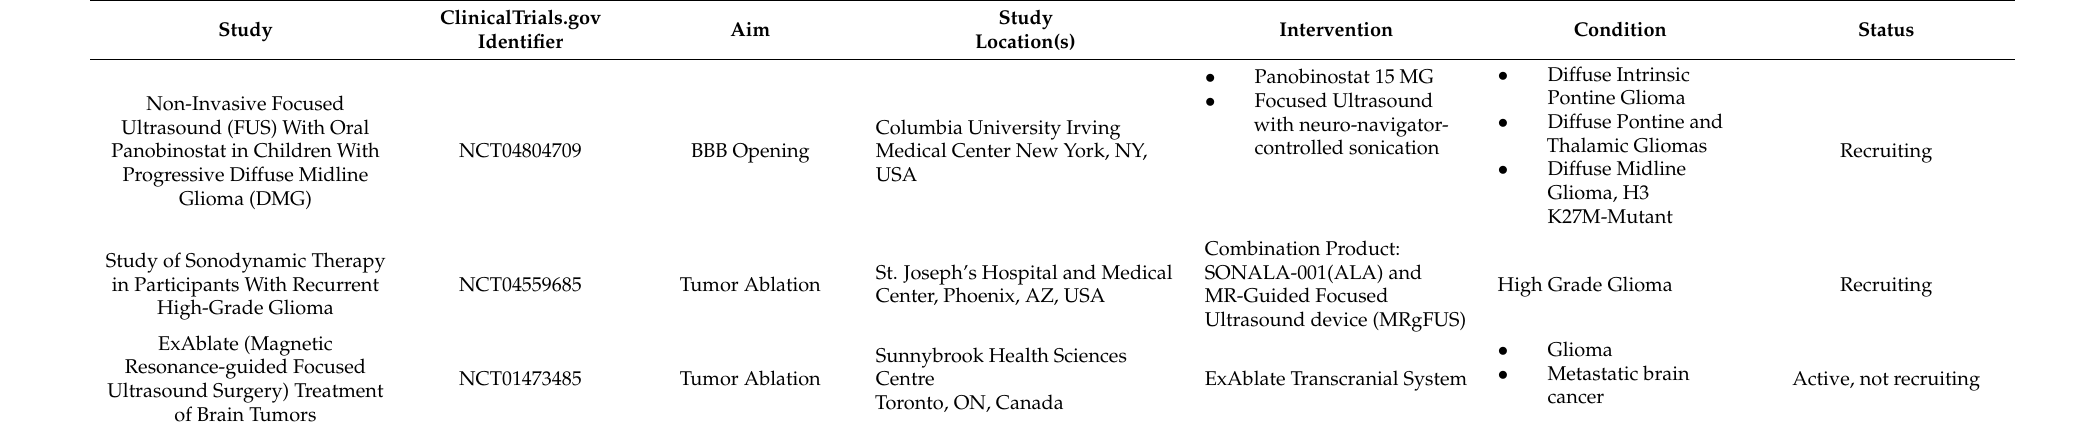
Table 6. FUS clinical ongoing trials characteristics and